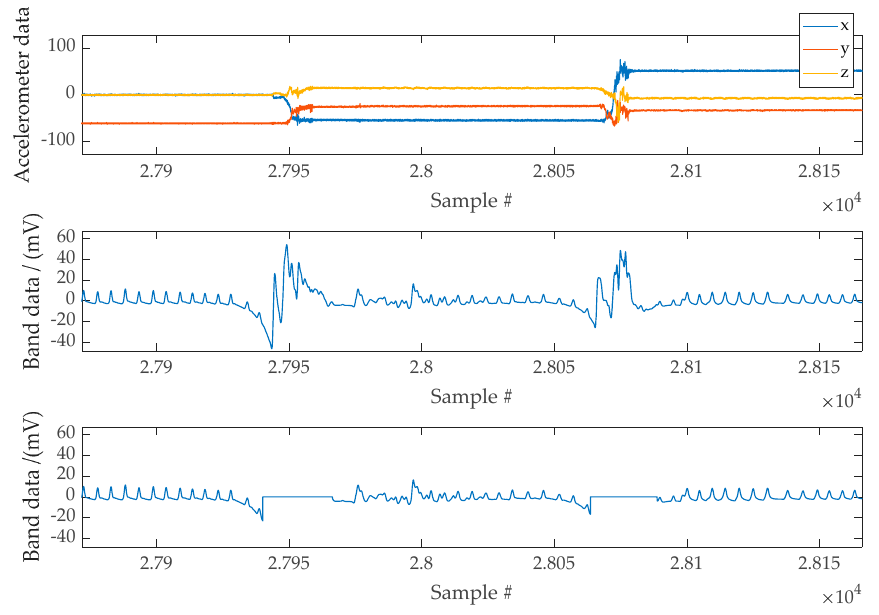
Figure 8. Top Panel: Example of accelerometer data used to mask high activity regions. Middle Panel: Band data affected by moving artefacts. Bottom Panel: Band data following the masking of movement artefacts.